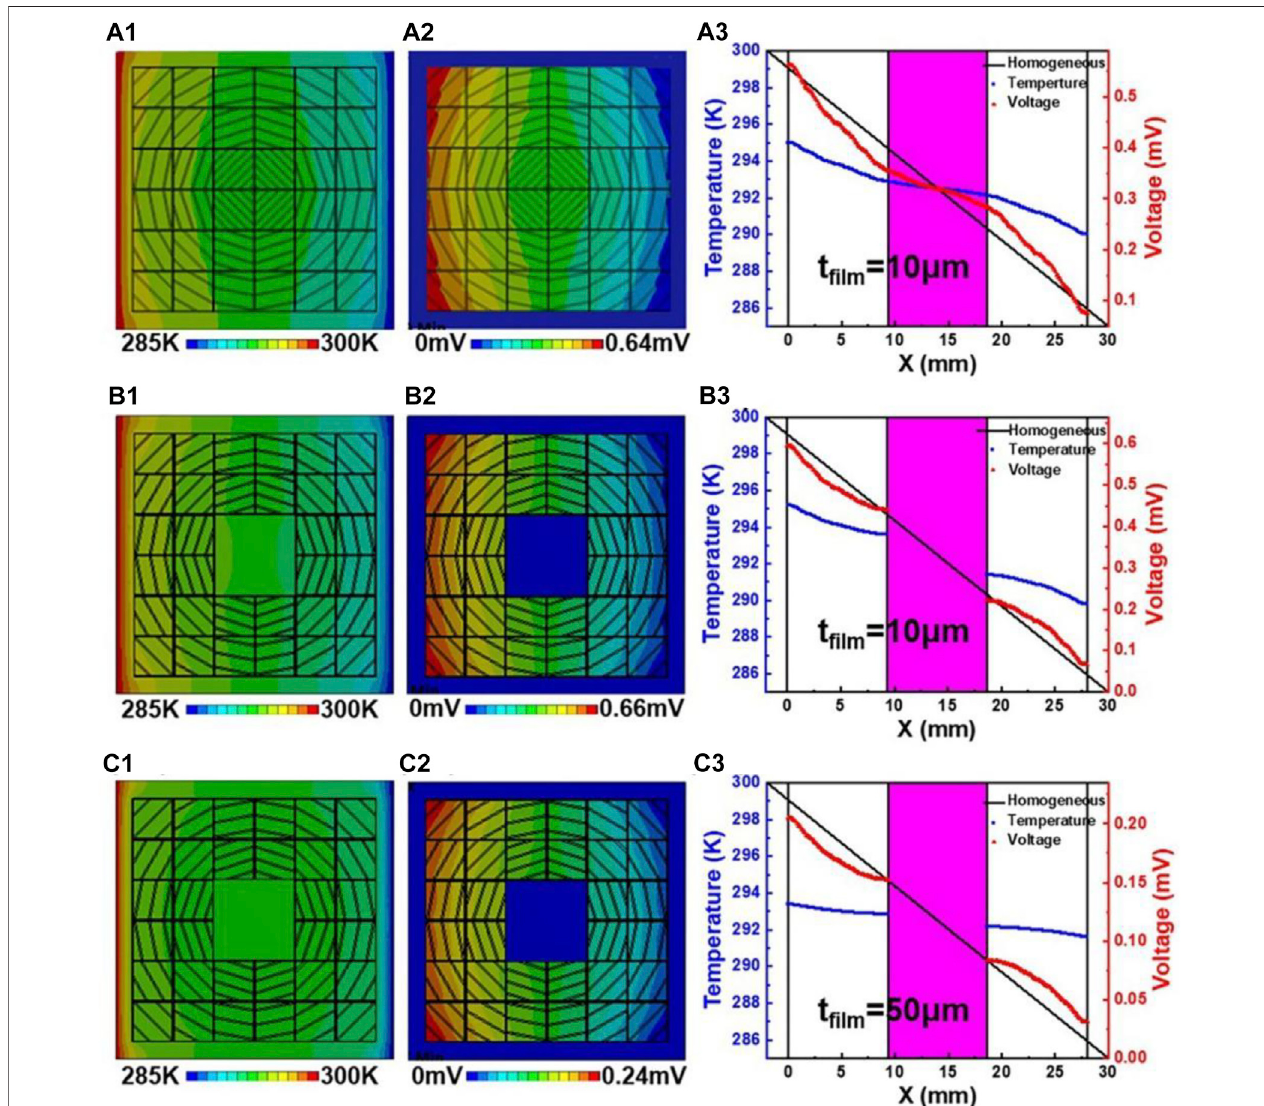
FIGURE 4 | Simulated results of dual-functional thin- fi lm thermal meta-devices. (A1 – C1) and (A2 – C2) Surface views of temperature distribution and voltage distributionofthedual-functionalthin- fi lmthermalmeta-devices,respectively,when (A) thecenterregionexistsandthethicknessofthethin- fi lmis10 μ m, (B) thecenter region hollows out and the thickness of the thin- fi lm is 10 μ m, and (C) the center region hollows out and the thickness of the thin- fi lm is 50 μ m. (A3 – C3) represents the temperature and voltage curves along the center lines in (A1,2 – C1,2) , respectively.